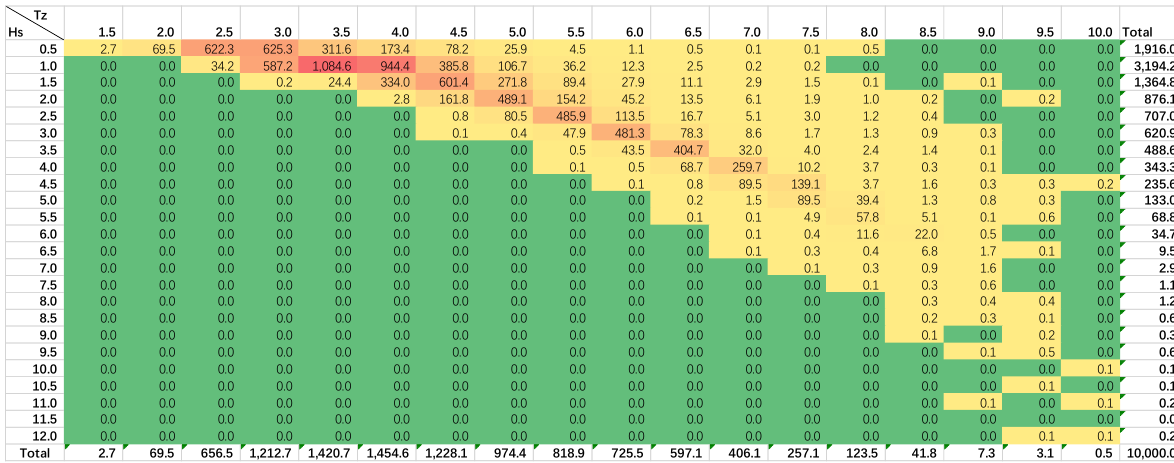
Figure 16. Wave scatter diagram at Site C.